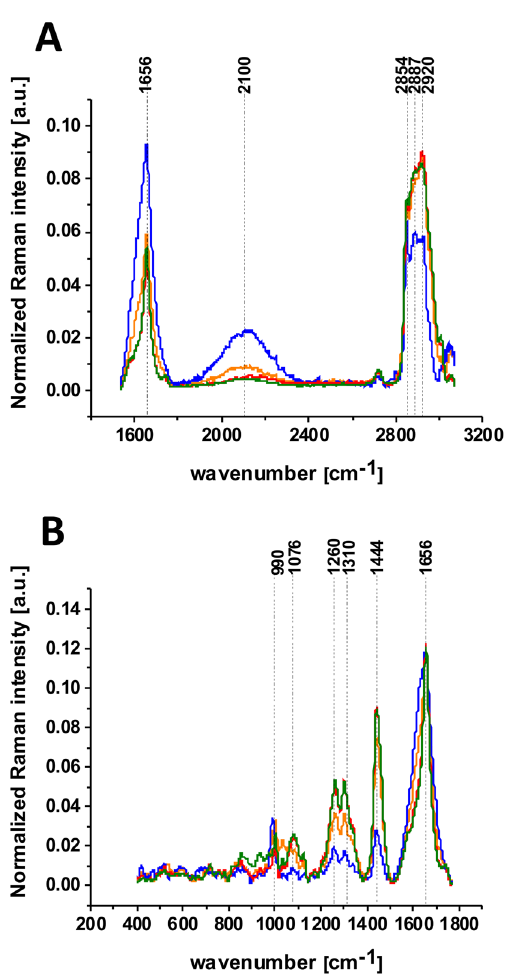
Figure 9. The average Raman spectra for human lung cells for lipid rich area supplemented with glucose 100 mM (orange line), deuterated glucose 100 mM (blue line), glucose 5 mM (green line) and deuterated glucose 5 mM (red line) in high frequency region ( A ) and in low frequency region ( B ); integration time 20 s, laser power 10